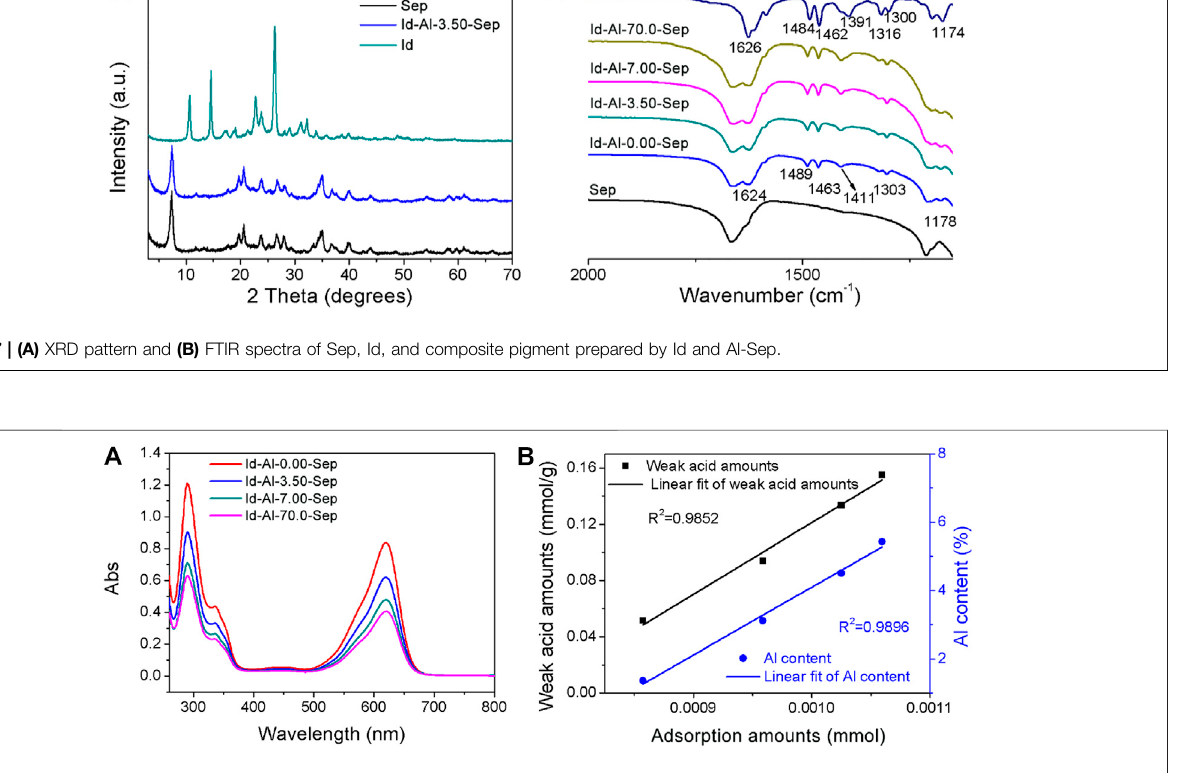
FIGURE8|(A) TheUV-Vis spectra ofsupernatant ofcomposite pigments desorbed in DMSO. (B) Linear correlationbetweenthe amount ofweak acid,Alcontent in Al-Sep, and the adsorption amount of Id in composite pigment desorbed by DMSO.